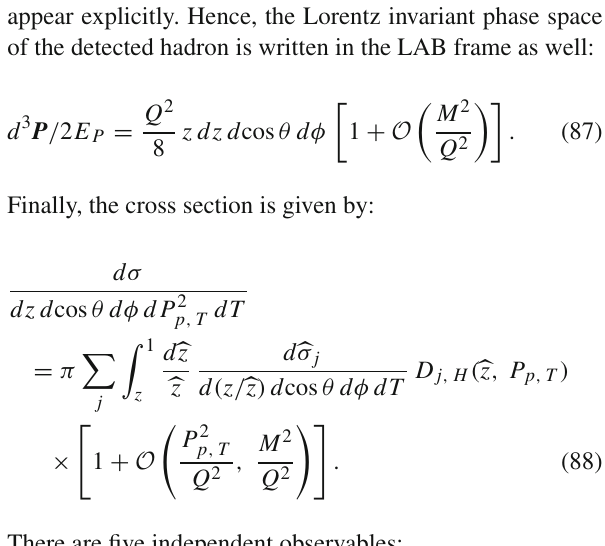
Fig. 6 a Pictorial representation of (cid:6) W to the topology of the final state associated to the value of the thrust T . All the quantities are totally predicted by perturbative